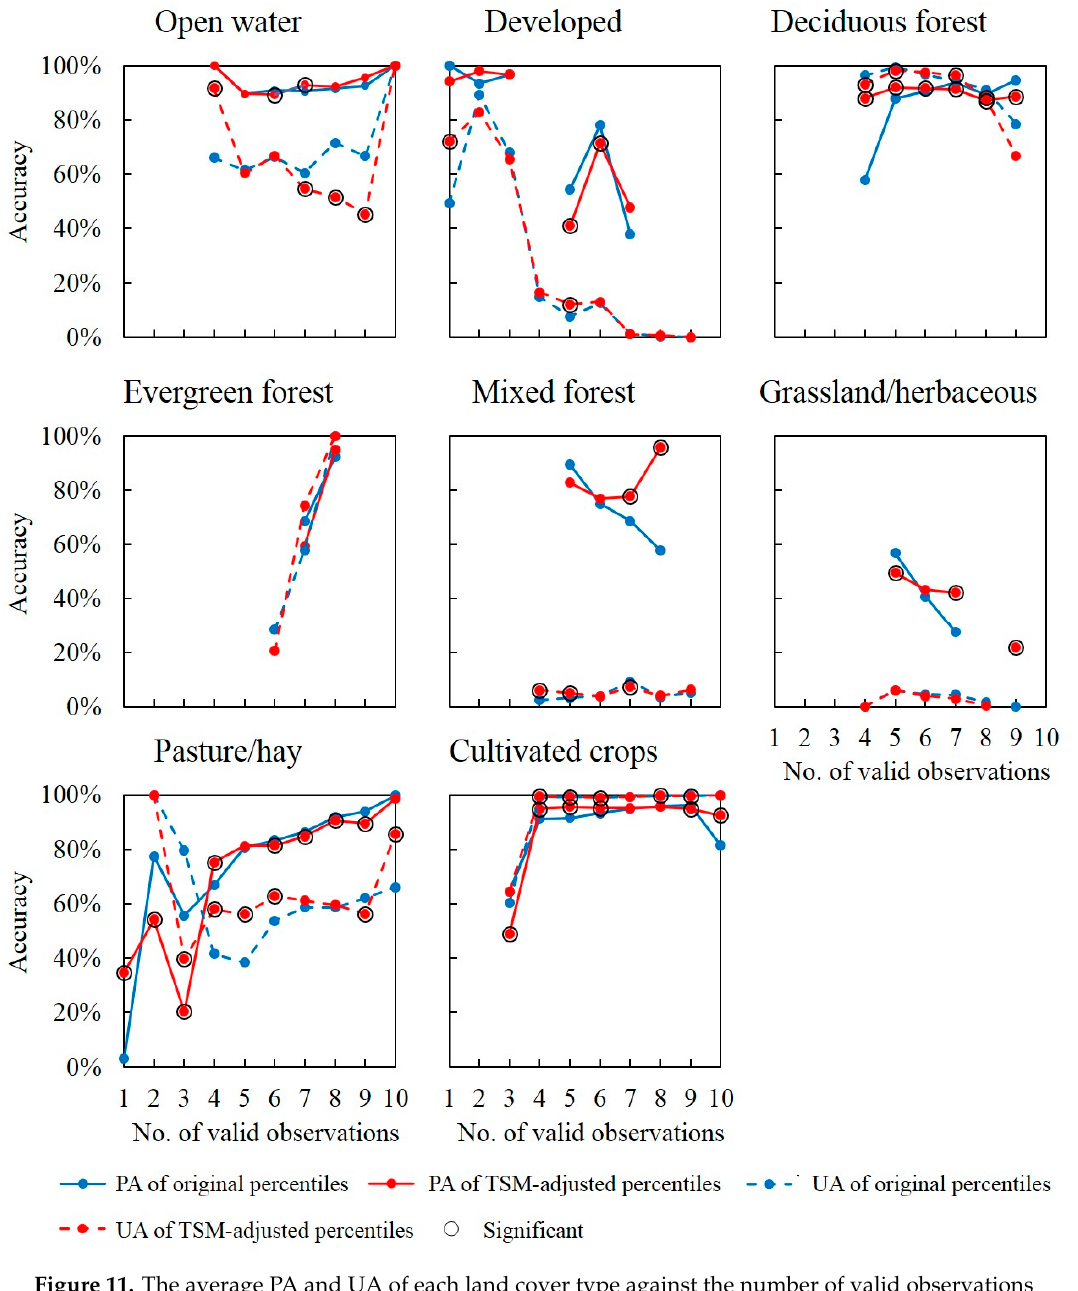
Figure 11. The average PA and UA of each land cover type against the number of valid observations in Iowa study area. Note that the black circles indicate that the accuracies obtained using the TSM-adjusted percentiles are significantly (at the 5% level) different from the accuracies obtained using the original percentiles.